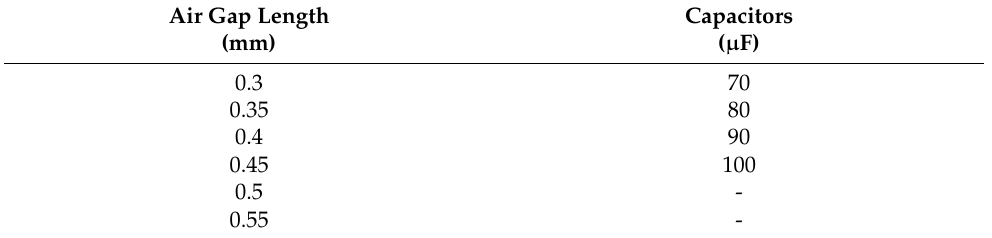
Table 3. Selected